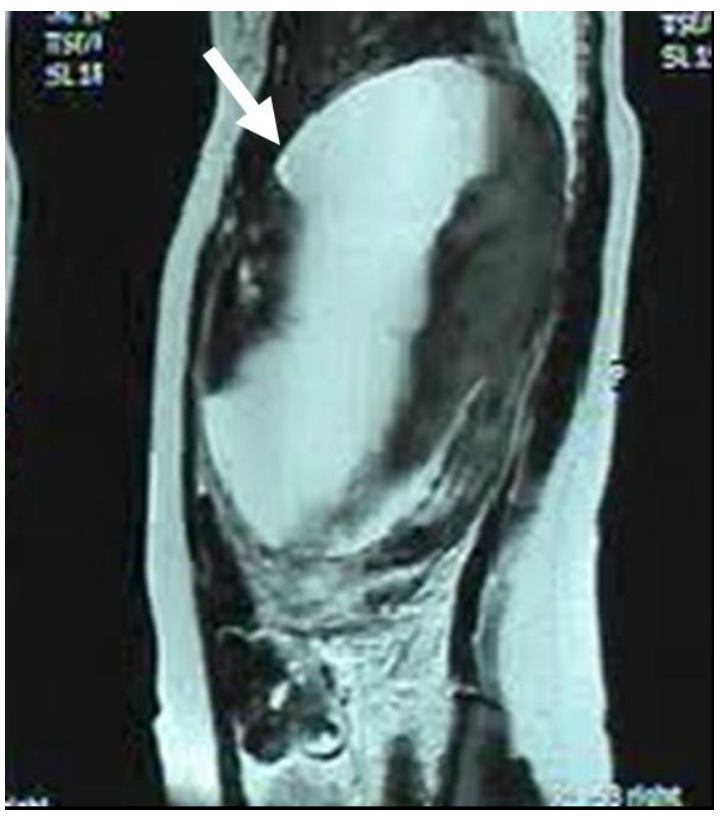
FIGURE 3. MRI shows a large mass (white arrow) in right-side upper abdomen extending into right lumbar and right iliac fossa with areas of hypointensity, measuring 14 × 16 cm in size.